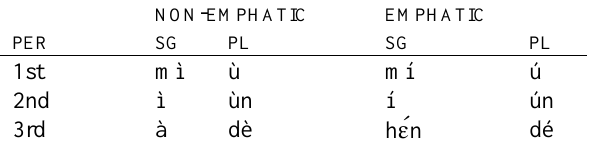
Table VI: Emphatic and non-emphatic pronouns in Saramaccan NON - EMPHATIC